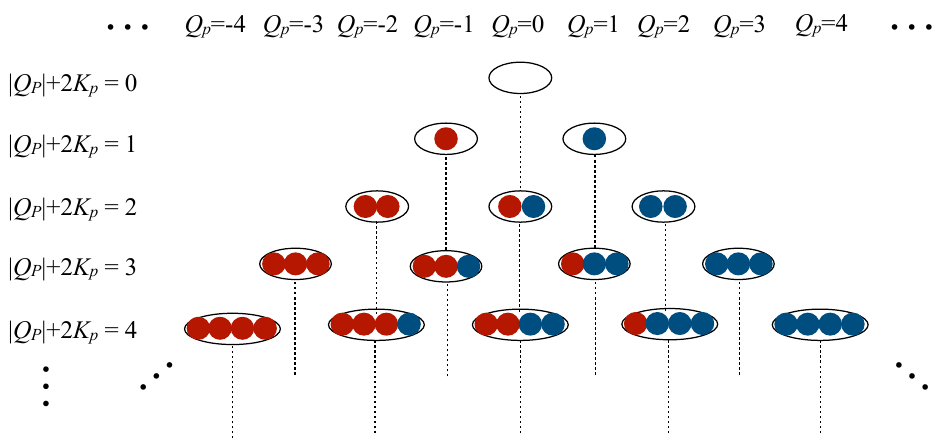
Figure 8 . Resurgence triangle exhibiting the complete resurgent structure is depicted, where blue points stand for instantons and red points for anti-instantons. We show the structure for each p . Thus, there are N copies of this structure in total. By summing up all of the p -sectors, the cancellation among the p -sectors arises and the contribution only from the Q Q p ∈ N Z